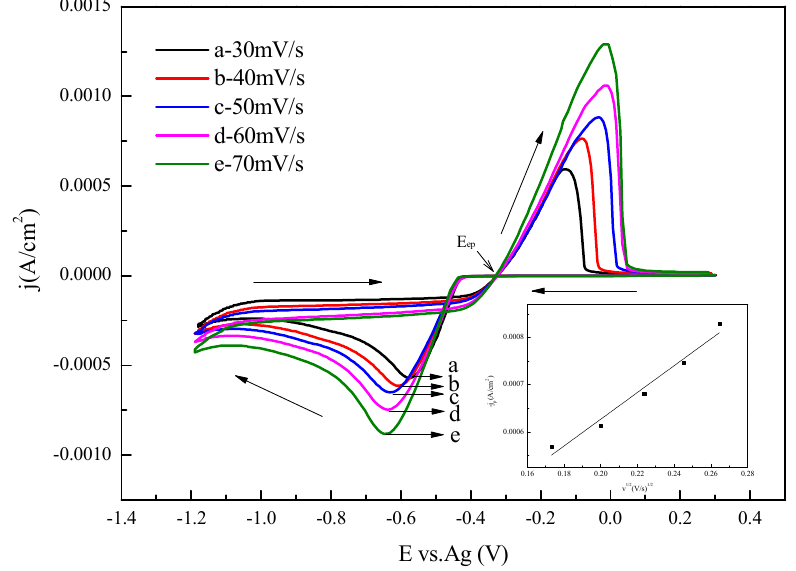
Figure 1. Cyclic voltammograms (CV) with different scan rates in ChCl–urea containing 0.2 M SnCl 2 at 323 K (the bottom right corner of the figure is the relationship between the cathodic peak current density ( j p ) and the square root of scan rate ( v 1/2 )).